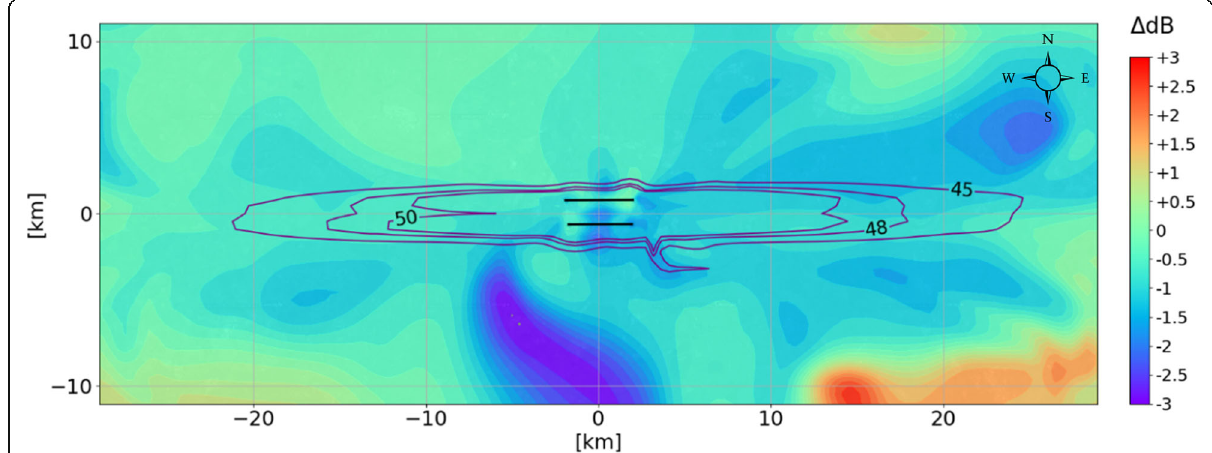
Fig. 3 Map of predicted variations in L Aeq,night at Heathrow Airport from 2018 to 2025 due to fleet substitution ( Δ dB = L Aeq,night,2025 - L Aeq,night,2018 ). 45-dB, 48-dB and 50-dB L Aeq,night contour lines computed for 2018 are superimposed